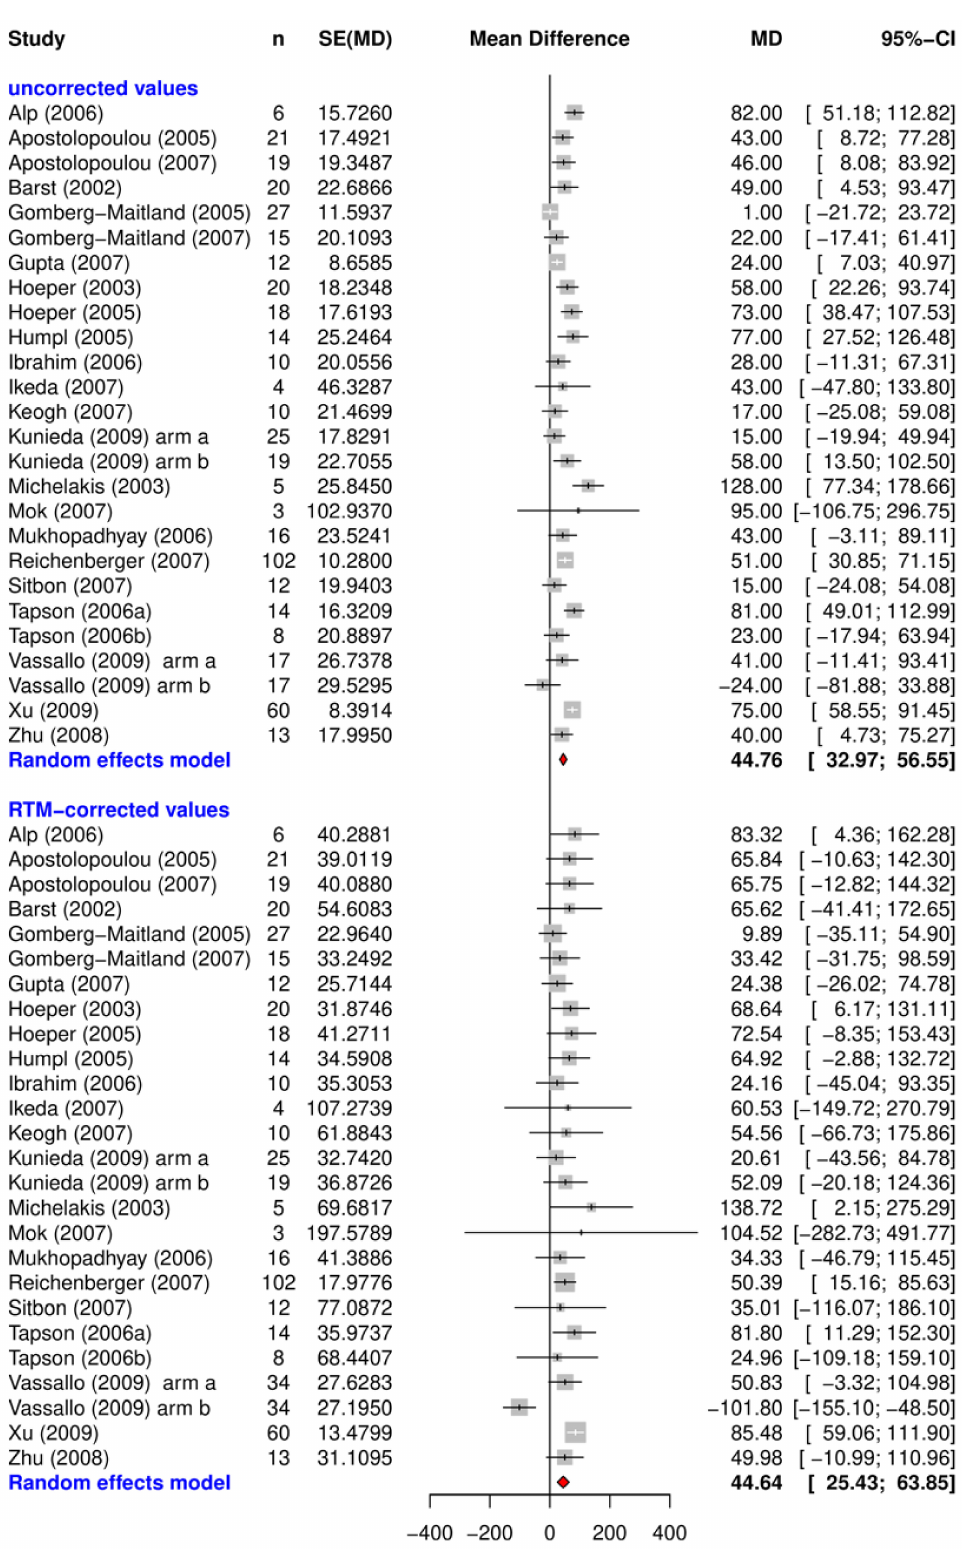
Figure 3. Uncorrected and RTM-corrected treatment effects measured with the 6MWD after 12 weeks from open label studies. Abbreviations: n = number of participants in study (arms); seTE = standard error of treatment effect; MD = mean difference; 95% CI = 95% confidence